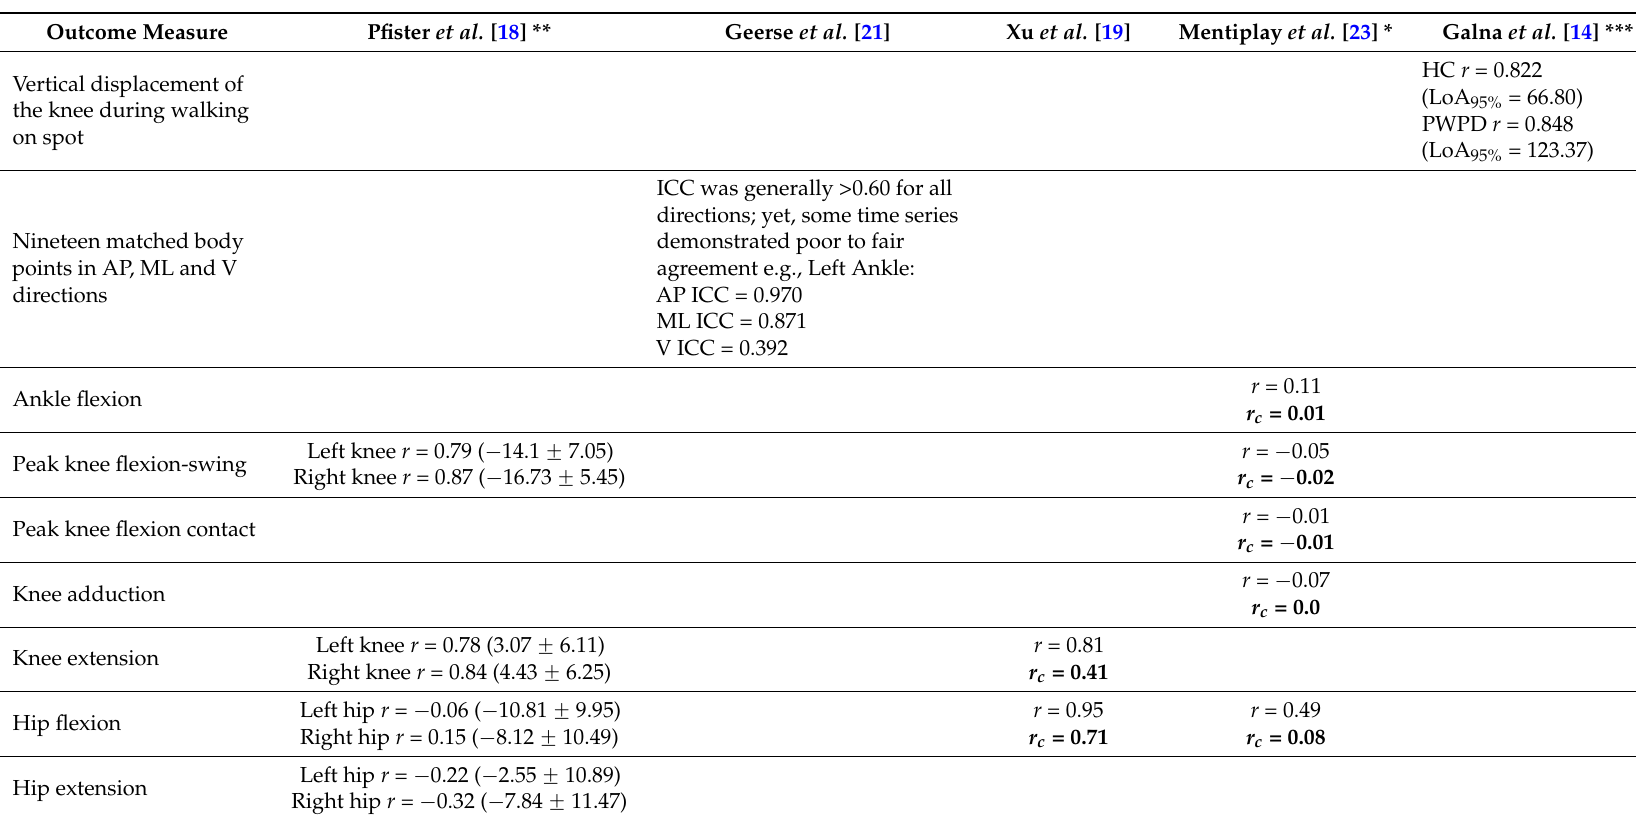
Table 4. Correlation coefficient ( r ), Concordance correlation coefficients ( r c ), and Intraclass correlation coefficient (ICC) of gait parameters measured by Kinect and gold standard. (Kinematic